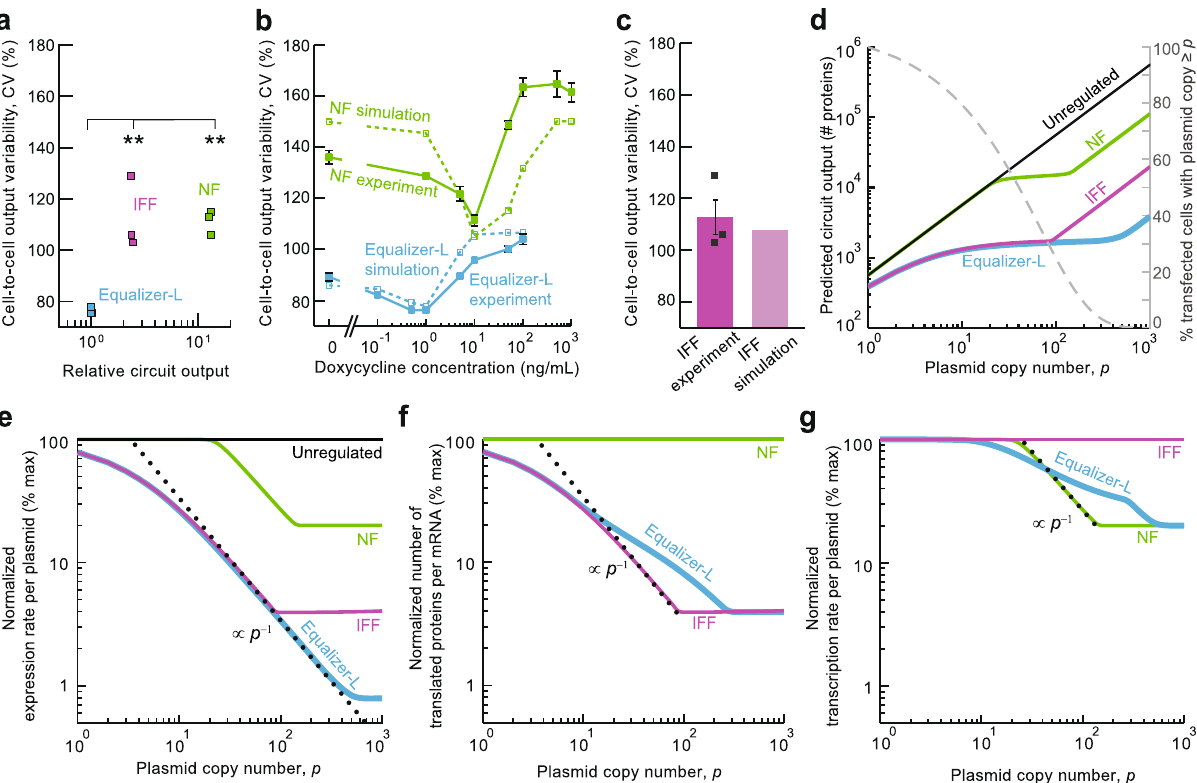
Fig. 4 Equalizer-L combines NF and IFF circuitry to increase the range of gene dosage compensation. a Equalizer-L produced lower cell-to-cell variability than either NF or IFF circuits alone. In this experiment and in simulations ( d – g ), doxycycline was used at the concentration producing the lowest cell-to-cell variability for each circuit (Equalizer-L, 1 ng/mL; NF, 10 ng/mL). ** p < 0.01 (Tukey ’ s multiple comparison test). Square markers indicate n = 3 independent transfections. Simulation results closely matched the experimentally determined cell-to-cell output variability of the NF ( b ) and IFF ( c ) circuits. For b , the fi lled markers indicate the mean of n = 3 independent transfections per construct. For c , the square markers indicate independent transfections. The error bars are the SEM. Each simulation datapoint (open markers) was computed from 10,000 cells whose plasmid copy number was sampled from the estimated plasmid copy number distribution. See Supplementary Notes 1, 3, and 5 for simulation models and methods. d Deterministic simulations predicted that Equalizer-L has a wider compensation range than standalone NF and IFF circuits. The dashed gray curve (right axis) illustrates the estimated plasmid copy number distribution. Simulated overall expression rate ( e ), number of proteins translated per mRNA ( f ), and transcription rate per plasmid ( g ) for each topology. The dotted lines indicate the slopes corresponding to perfect dosage compensation. Source data are provided as a Source Data fi